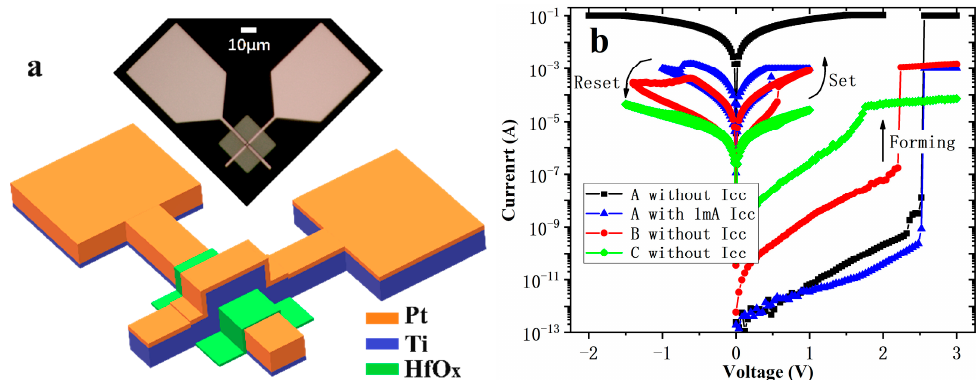
Figure 1. The structure and I-V characteristics of the 2 × 2 μ m 2 devices with 10 nm thick HfO x . ( a ) the structure diagram and optical micrograph of the devices; ( b ) forming and typical set/reset characteristics of Device A, B, and C.